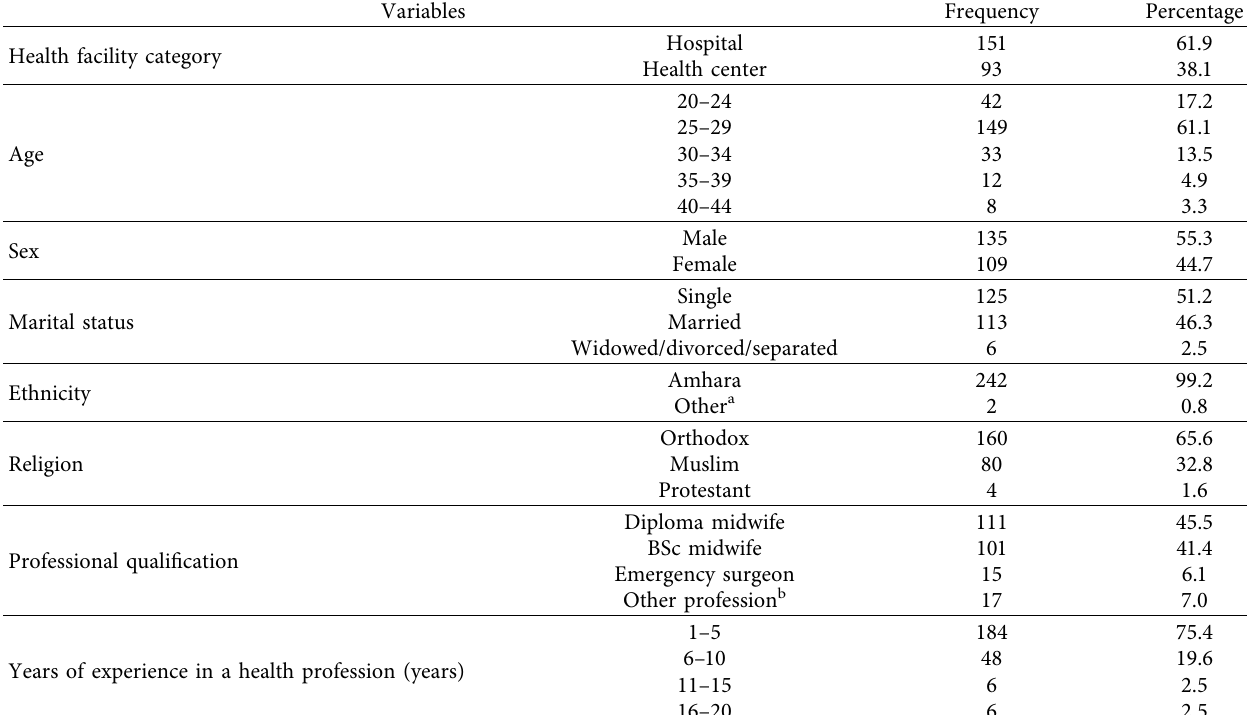
Table 1: Socio-demographic characteristics and type of health facility of maternity ward healthcare professionals in South Wollo zone health facilities, North West Ethiopia,